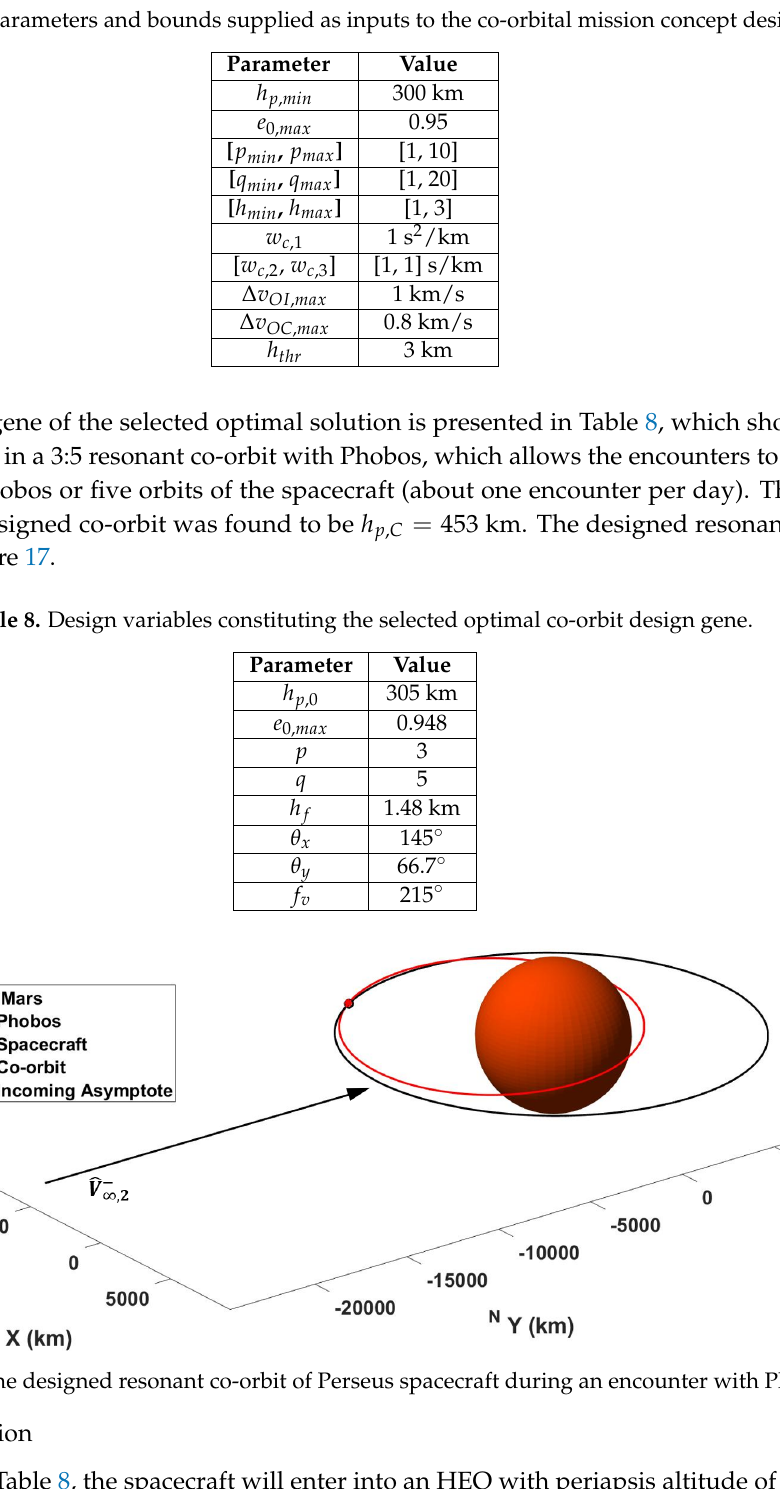
Figure 17. The designed resonant co-orbit of Perseus spacecraft during an encounter with